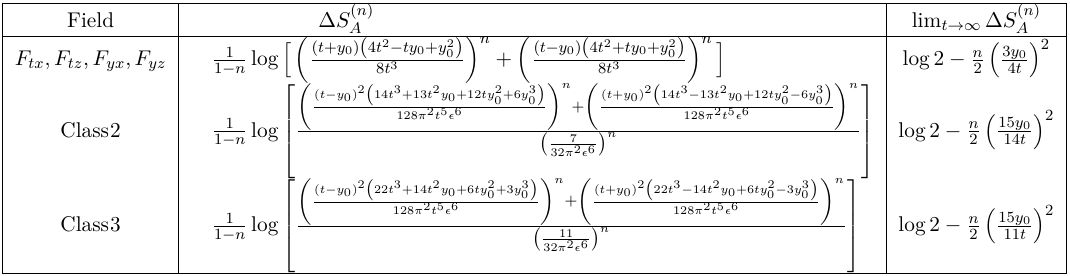
Table 3 . Rényi entropy growth of vectors under SO(2) T × SO(2) L . The order of the polynomial in r = y 0 /t is 2 s + 1 . The power of the pre-factor (1 + r ) is one less that the scaling dimension of the field. Class 2 , 3 together contain 8 curvature components which can be organized as vectors of SO(2) T × SO(2) L